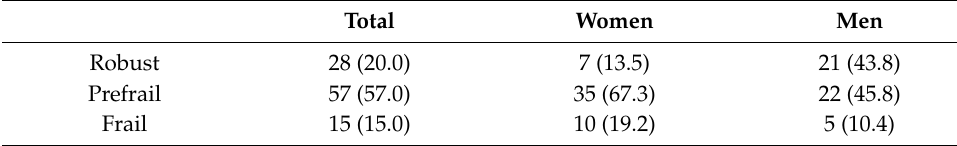
Table 2. Frailty prevalence in the complete cohort of patients with type 2 diabetes and by gender.